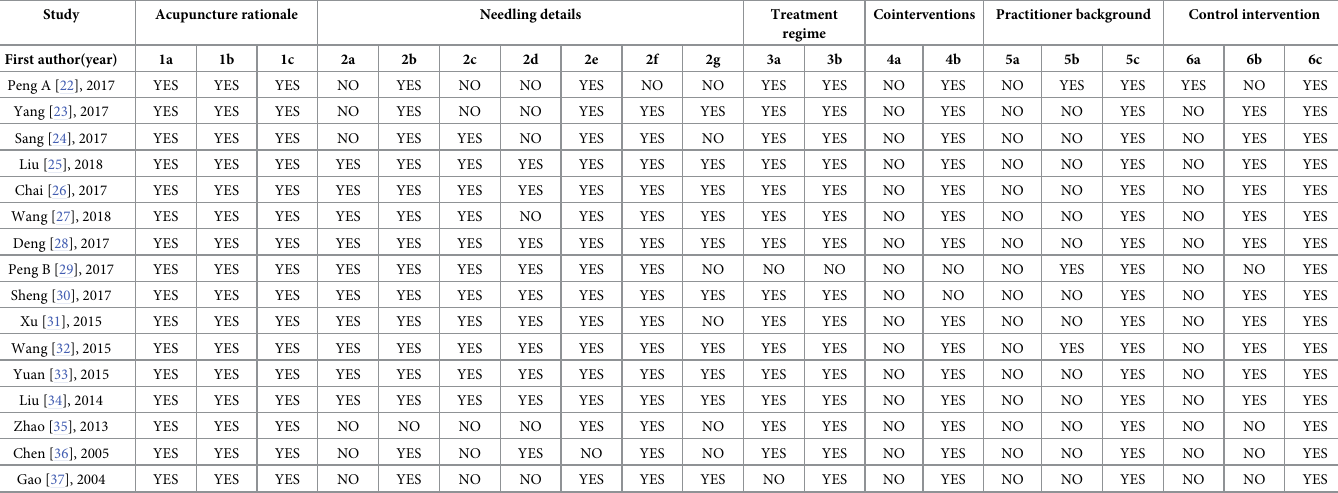
Table 4. STRICTA, Standards for Reporting Interventions in Controlled Trials of